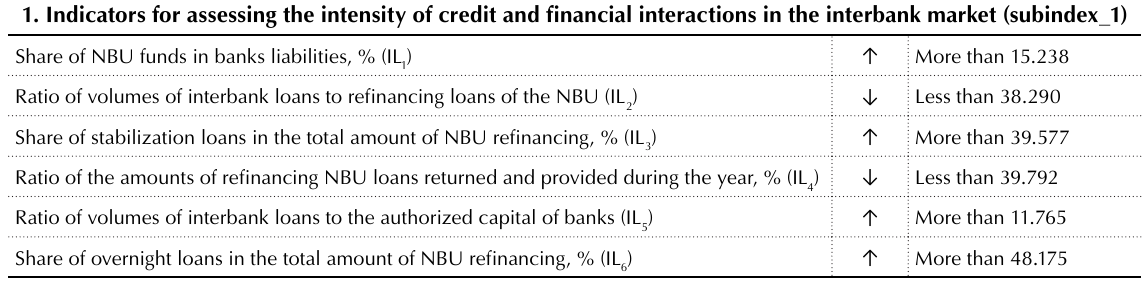
Source: Lesik (2017). Course of changes in the crisis period and threshold values of indicators signaling its